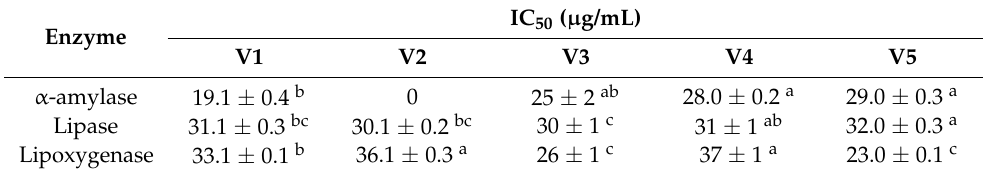
Table 3. The enzyme inhibition results (IC50 values; µ g/mL) of the microencapsulated powders.